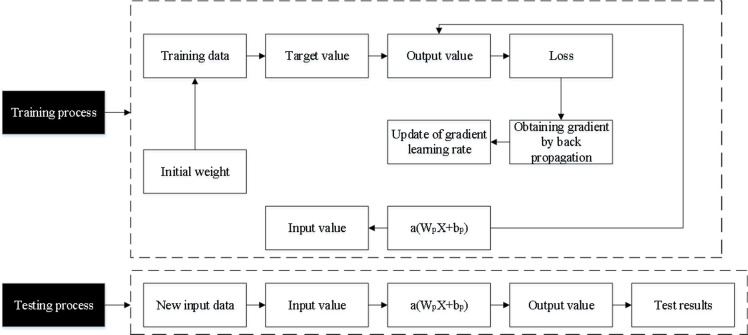
The training and testing processes of DNN.